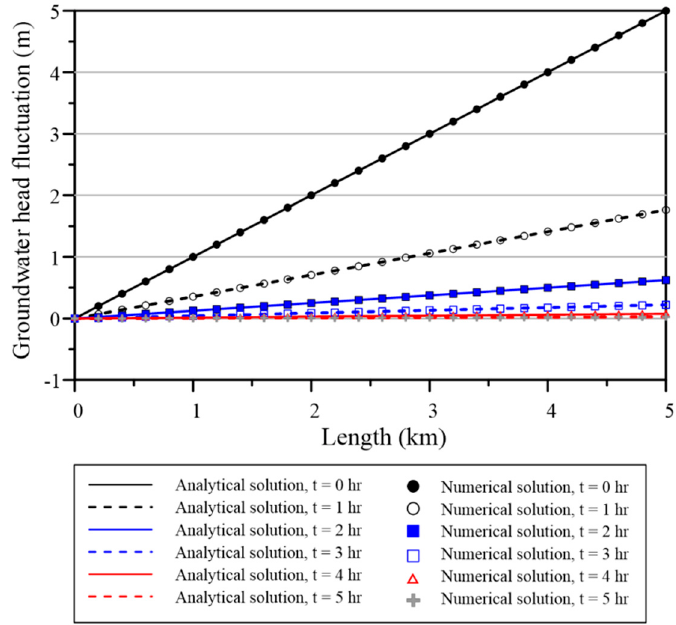
Figure 3. The basis function order versus the maximum absolute error (MAE).